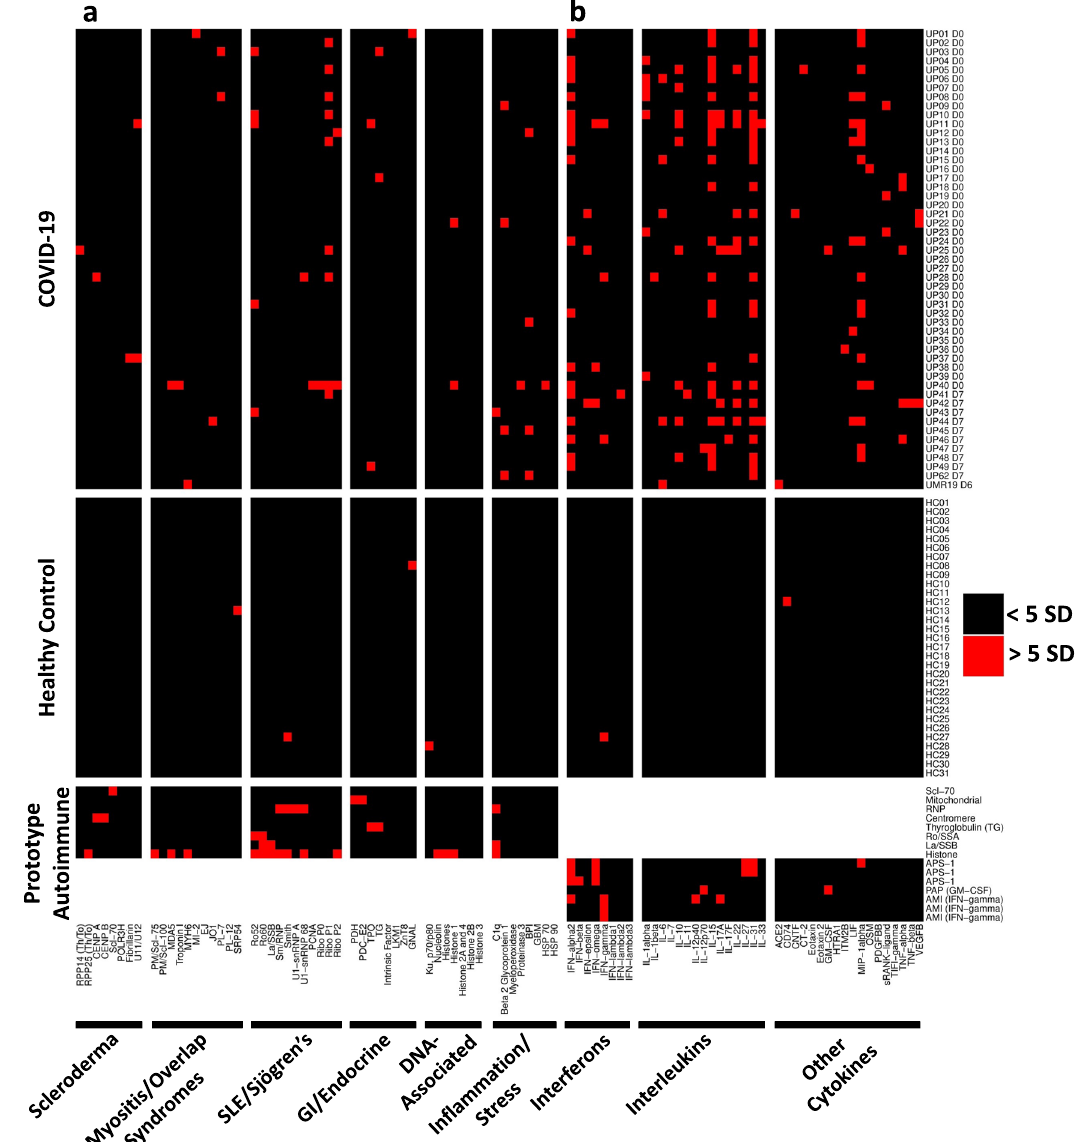
Fig. 1 High prevalence of autoantibodies in hospitalized COVID-19 patients. a Heatmap depicting serum IgG antibodies discovered using a 53-plex bead- based protein array containing the indicated autoantigens ( x -axis). Autoantigens are grouped based on disease (scleroderma, myositis, and overlap syndromes such as mixed connective tissue disease (MCTD), SLE/Sjögren ’ s, gastrointestinal and endocrine disorders), DNA-associated antigens, and antigens associated with tissue in fl ammation or stress responses. COVID-19 patients (top panel), HC ( n = 31, middle panel), and 8 prototype autoimmune disorders (bottom panel) are shown. Colors indicate autoantibodies whose MFI measurements are >5 SD (red) or <5 SD (black) above the average MFI for HC. MFIs <3000 were excluded. b Heatmap using a 41-plex array of cytokines, chemokines, growth factors, and receptors. The same samples in Panel A were also analyzed for anti-cytokine antibodies (ACA). Cytokines are grouped on the x-axis by category (interferons, interleukins, and other cytokines/ growth factors/receptors). Prototype samples from patients with immunode fi ciency disorders include three patients with Autoimmune Polyendocrine Syndrome Type 1 (APS-1), one patient with Pulmonary Alveolar Proteinosis (PAP), and three patients with Atypical Mycobacterial Infections (AMI). Colors indicate autoantibodies whose MFI measurements are >5 SD (red) or <5 SD (black) above the average MFI for HC. MFIs <3000 were excluded. Source data are provided as a Source Data fi